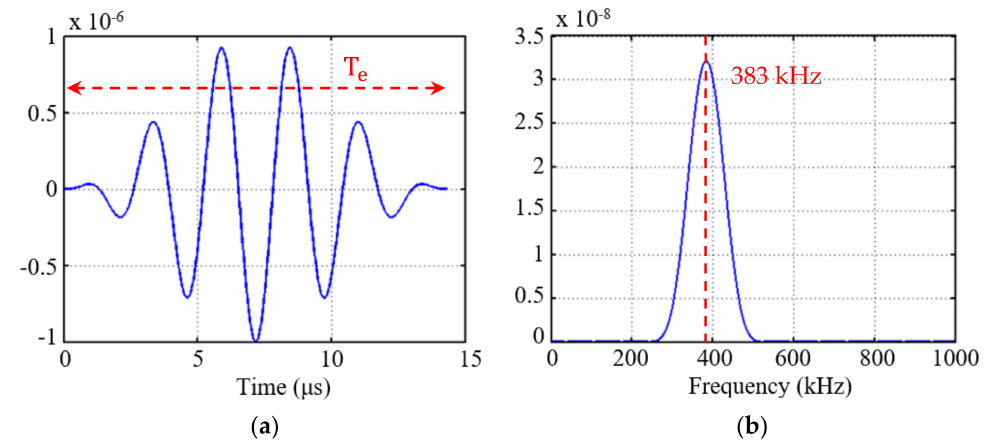
Figure 3. The 383 kHz excitation signal: ( a ) time domain; ( b ) frequency